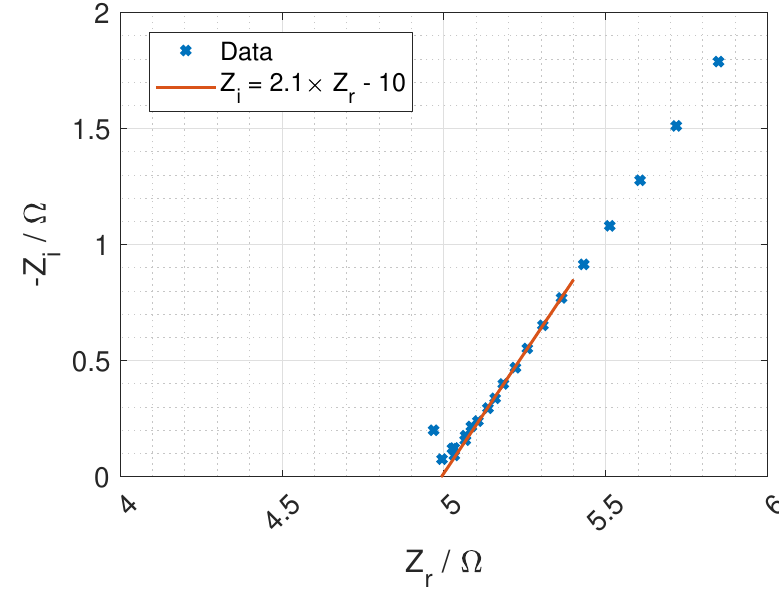
Figure 10. Impedance data with linear fit to find the crossing of the real axis.